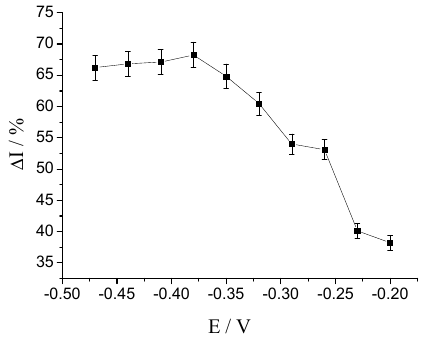
Figure 5. The effect of different potentials on the response of hFc γ Rn receptor biosensors. The detection potentials were − 0.2 V, − 0.23 V, − 0.26 V, − 0.29 V, − 0.32 V, − 0.35 V, − 0.38 V, − 0.41 V, − 0.44 V, and − 0.47 V.